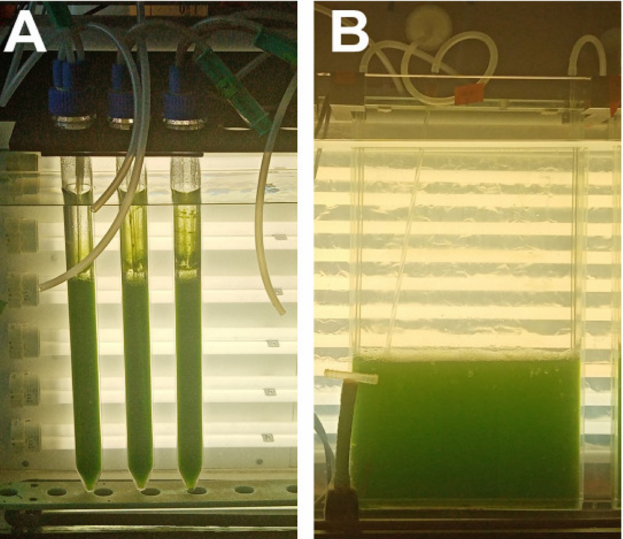
Figure 1. Laboratory photo-bioreactors used for the experiments. ( A ) glass cylinders (300 mL), ( B ) plane-parallel cuvettes (2500